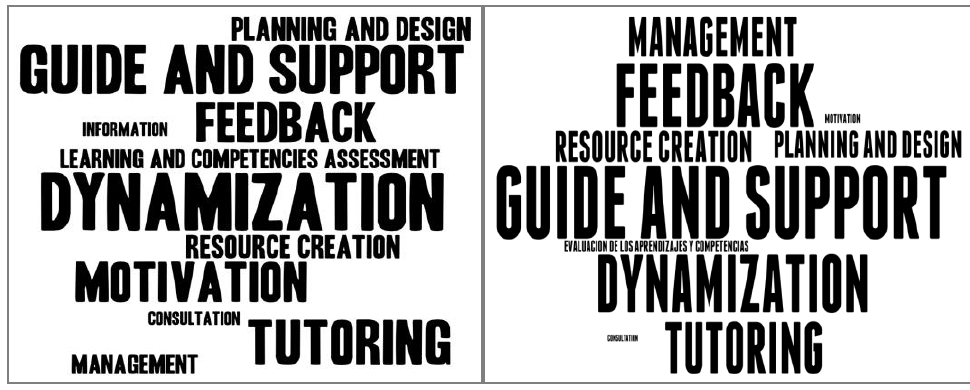
Figure 6. Comparison of the "tag clouds" for the definition of teachers’ or tutors’ functions in a MOOC used by teachers from a traditional university and a virtual